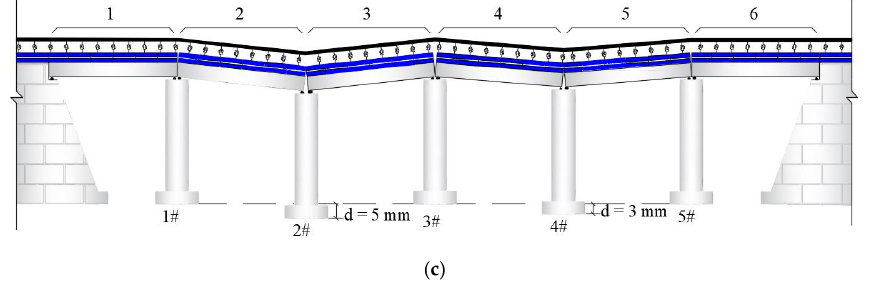
Figure 5. Deformation diagram of the bridge during pier settlement. ( a ) The settlement of a single pier. ( b ) The uneven settlement of two adjacent piers. ( c ) The uneven settlement of two separated piers.